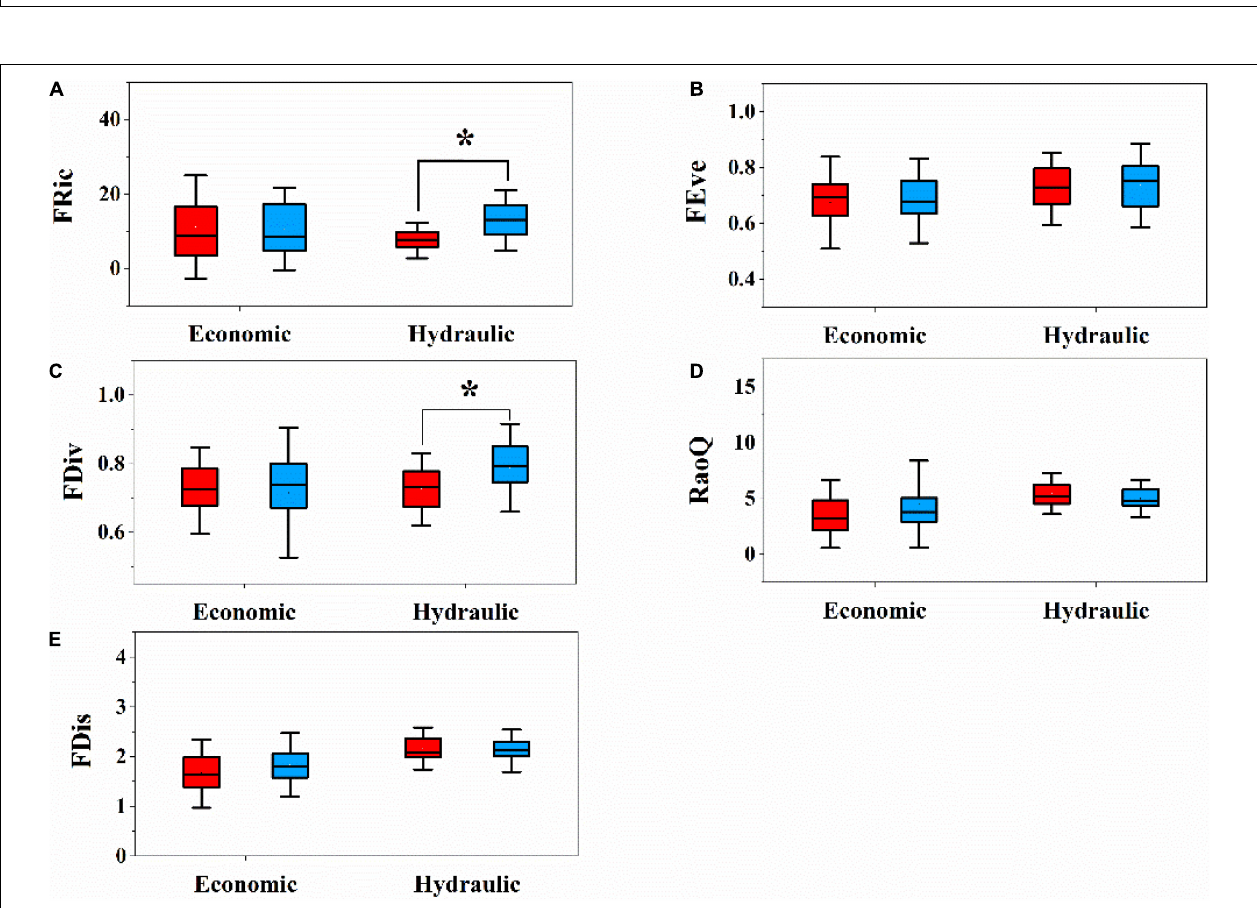
FIGURE 4 | Difference of functional diversity components in relation to hydraulic traits and economic traits between LP and QL. (A) Functional richness (FRic); (B) functional evenness (FEve); (C) functional divergence (FDiv); (D) Rao’s quadratic entropy (RaoQ); (E) one-dimensional functional richness (FDis); different letters above bars indicate statistically significant differences at P <